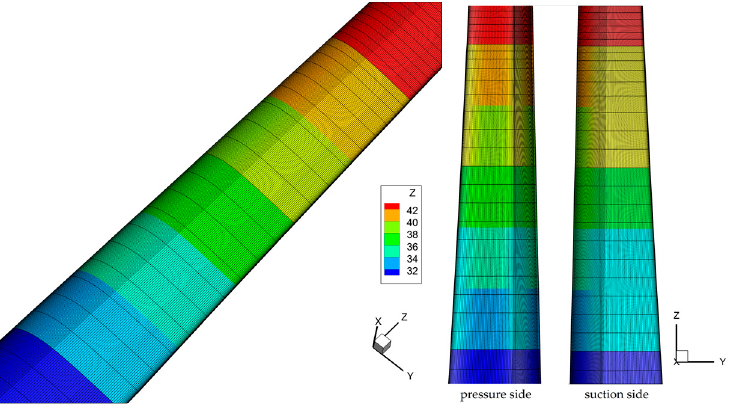
Figure 21. The grids of 3D rotating blade.